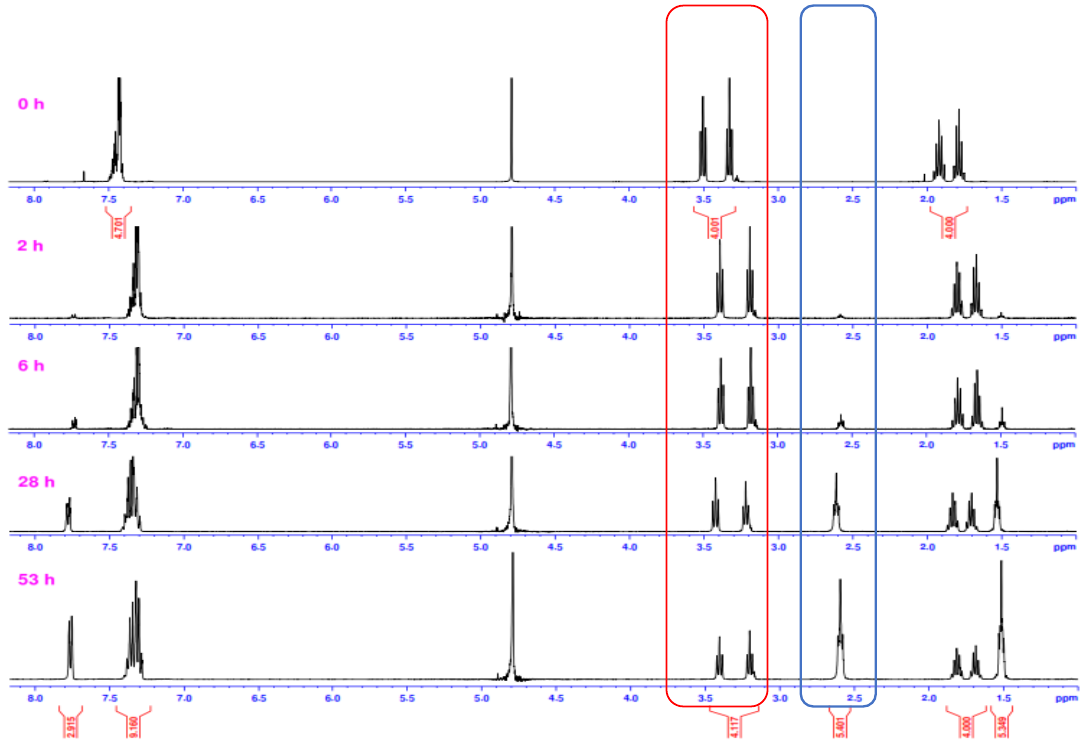
Figure 7. 1 H-NMR monitoring of the hydrolysis of 3a , with NaOH in D 2 O and 1,4-dioxane- d 8 at 70 °C. The intensity of amide peaks decreased (red box) over time, and product signals appeared (blue box).